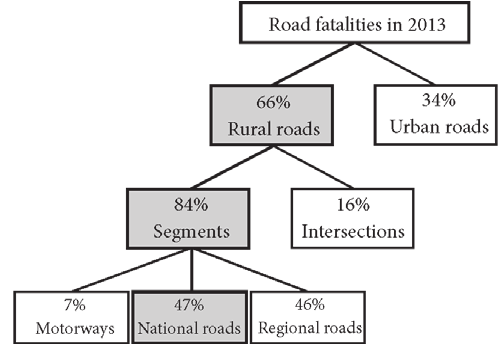
Fig. 1. Division of Czech road fatalities by road settings according to 2013 police